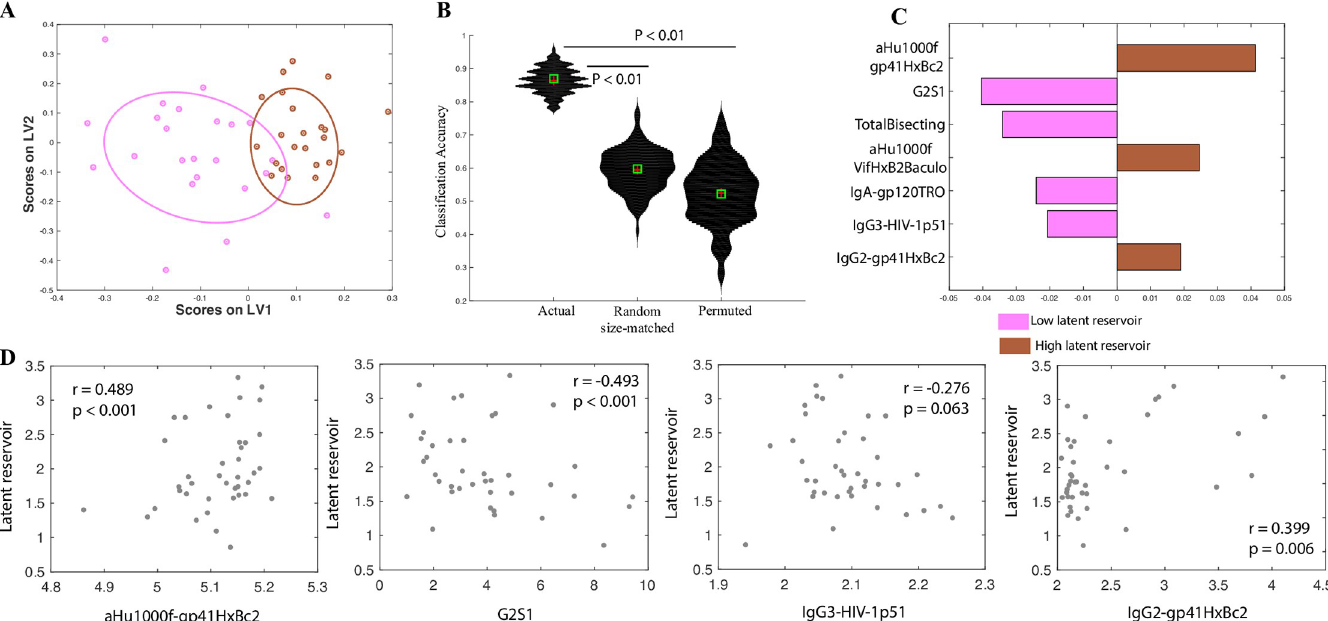
Fig 3. Correlates of latent reservoir size in controllers and chronic progressors. A. A LASSO-based model is used to classify controllers and progressors by latent reservoir size. The LASSO-selected features are visualized in 2 dimensions using a PLSDA LV scores biplot. B. Violin plots showing classification accuracy of the actual model from (a) and of 2 negative control models (based on randomly selected features & permuted data), as measured in a 5-fold cross validation framework. Exact P values (actual vs permuted and actual vs random-size matched) confirm significance of the model. C. PLS VIP plot corresponding to the features in (a) used to classify subjects by latent reservoir size. D. Correlations between biomarkers of the latent reservoir in controllers and progressors, and actual latent reservoir size.